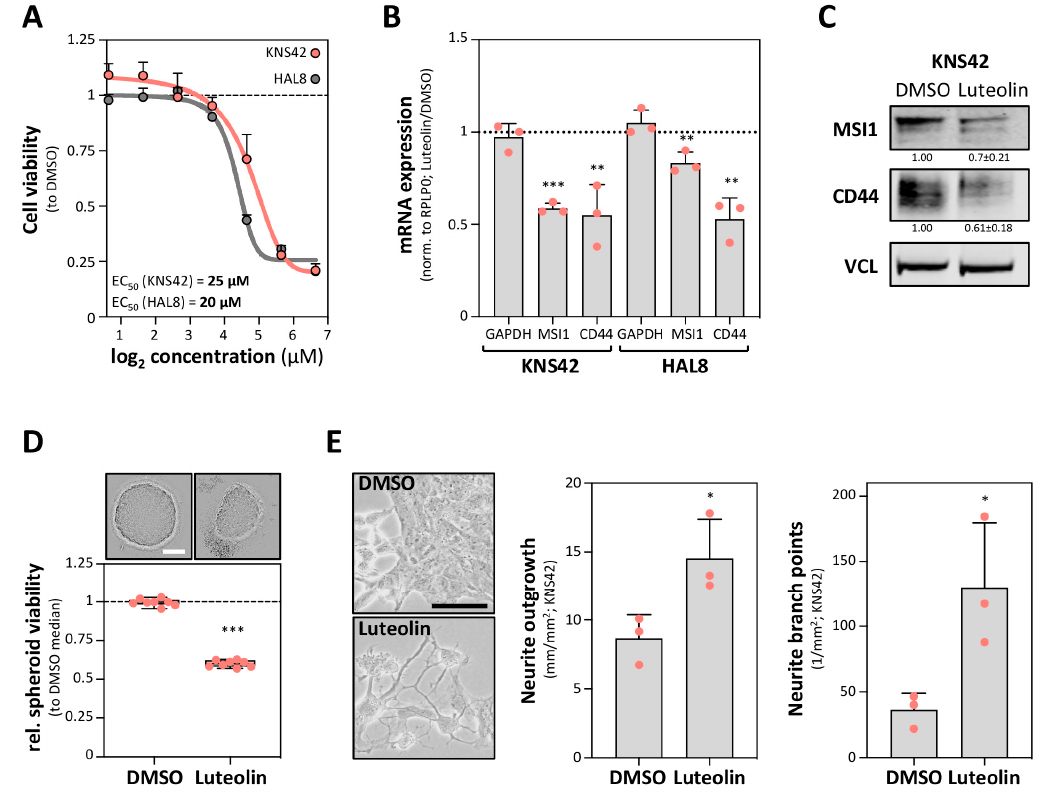
Figure 3. A luteolin treatment impairs CD44 expression and induces differentiation. ( A ) Cell viability ratios (to DMSO) of KNS42 cells and primary tumorspheres HAL8 exposed to different concentrations of MSI1-targeting luteolin for 72 h. Response curves and EC 50 values are shown. ( B ) Relative mRNA expression determined by RT-qPCR for the indicated transcripts upon luteolin treatment at EC 50 concentrations to DMSO after 72 h in KNS42 cells and the primary tumorspheres HAL8. ( C ) Representative Western blot analyses of the indicated proteins in KNS42 cells exposed to luteolin at EC 50 concentration and DMSO. VCL served as the negative and loading control. ( D ) Spheroid viability of the KNS42 cells exposed to luteolin at EC 50 concentration and DMSO, determined by CellTiter-GLO, 72 h after seeding. Upper panel, representative images of the spheroids; scale bar, 150 µ m. Lower panel: box plots showing the spheroid viability normalized to the median viability of the DMSO-treated cells (set to one). ( E ) Neurite growth parameters for the KNS42 cells exposed to luteolin at EC 50 concentration and DMSO after 72 h. Left panel: representative images of the KNS42 cells. Middle and right panels, quantification of the neurite outgrowth and branch points. Error bars indicate the standard deviation from three independent experiments. Statistical significance was determined by Student’s t -test (***, p ≤ 0.001; **, p ≤ 0.01; *, p ≤ 0.05). (cid:48) Deletion of the 3 UTR substantially impaired the CD44 protein and mRNA expression, as revealed (cid:48) by Western blotting and qRT-PCR in parental (WT) and ∆ CD44-3 UTR cells (Figure 4F,G). Despite an overall reduced CD44 expression, MSI1 depletion impaired CD44 protein and mRNA